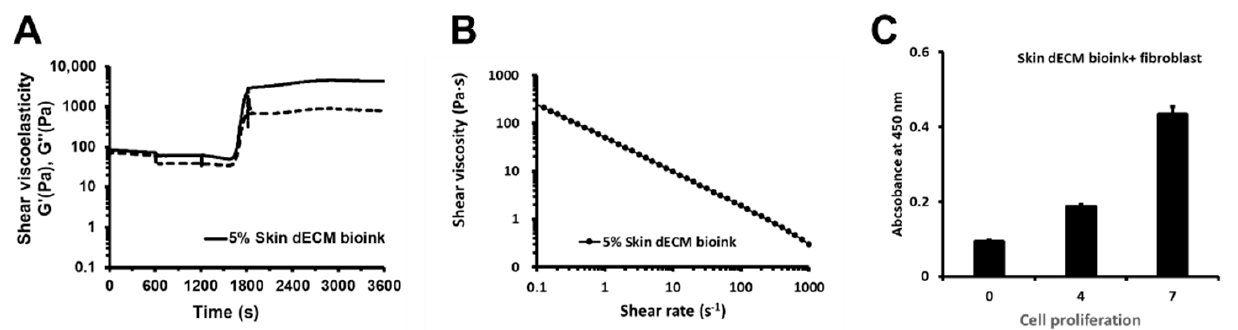
Figure 1. Rheological analysis of the bioink’s printability and cell proliferation of the 3D-printed skin bioink: ( A ) viscosity of the bioink; ( B ) viscoelasticity of the bioink; ( C ) cell proliferation of the 3D-printed skin bioink.